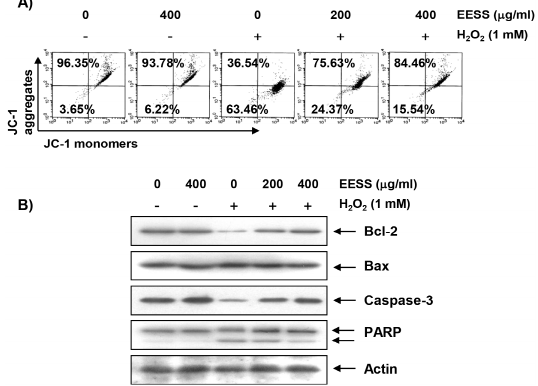
Figure 3. Attenuation of H 2 O 2 -induced mitochondrial dysfunction and changes of apoptosis-related proteins by EESS in SW1353 chondrocytes. Cells were pretreated with the indicated concentrations of EESS for 1 h, and then stimulated with or without 1 mM H 2 O 2 for 24 h. ( A ) The cells were collected and incubated with 10 μ M JC-1 for 20 min at 37 °C in the dark. The cells were then washed once with PBS, and the values of MMP were evaluated by flow cytometry. The data are the means of the two different experiments; ( B ) The cellular proteins were separated by SDS-polyacrylamide gel electrophoresis, and then transferred to membranes. The membranes were probed with the indicated antibodies. Proteins were visualized using an ECL detection system. Actin was used as an internal control.